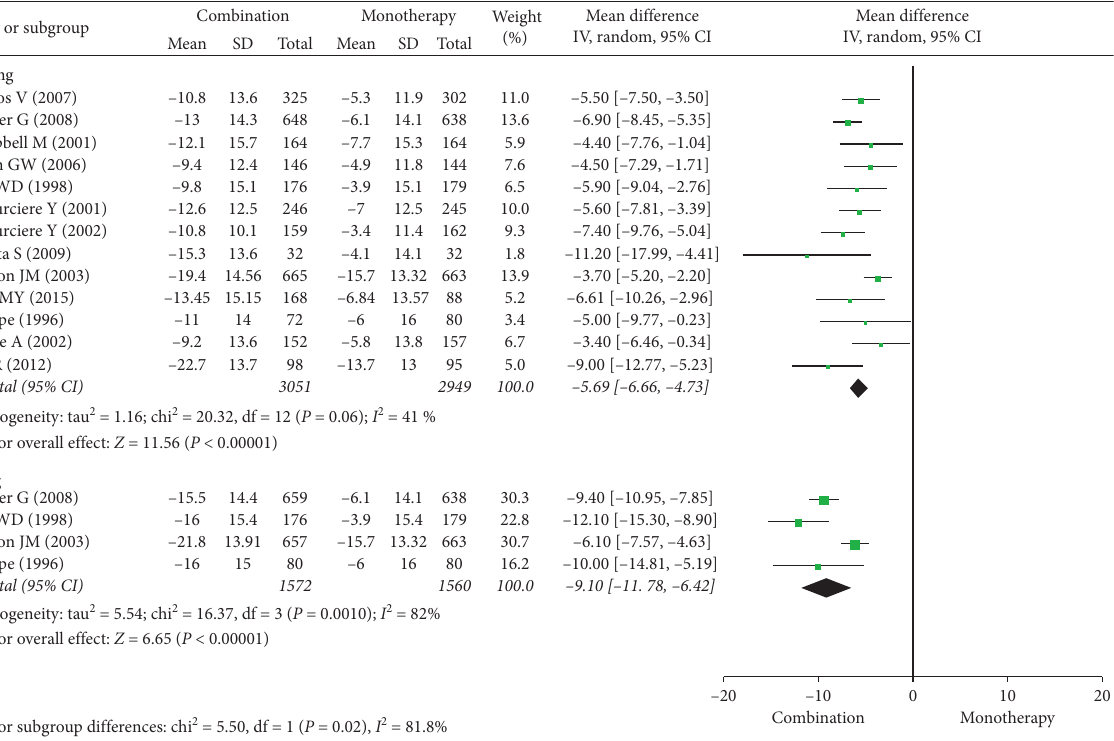
Figure 2: Forest plot for sitting systolic blood pressure (SiSBP)